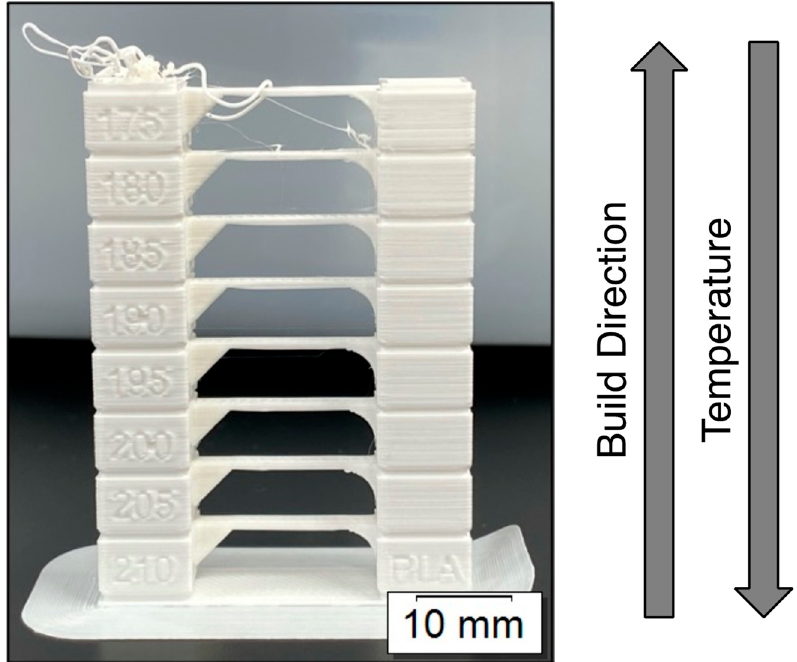
Figure 3. Example temperature tower used in Phase 1 to determine the optimal nozzle temperature for a given fi lament.